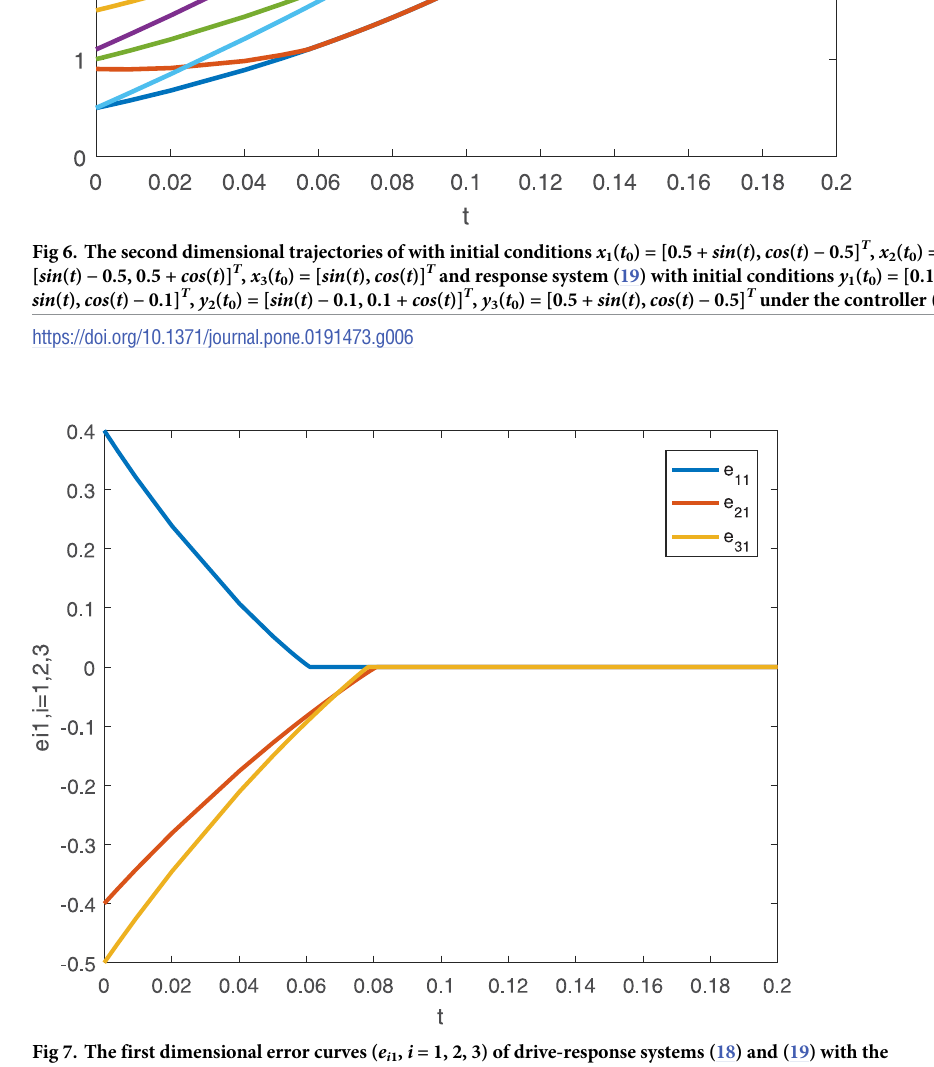
, i = 1, 2, 3) of drive-response systems (18) and (19) with the i 1